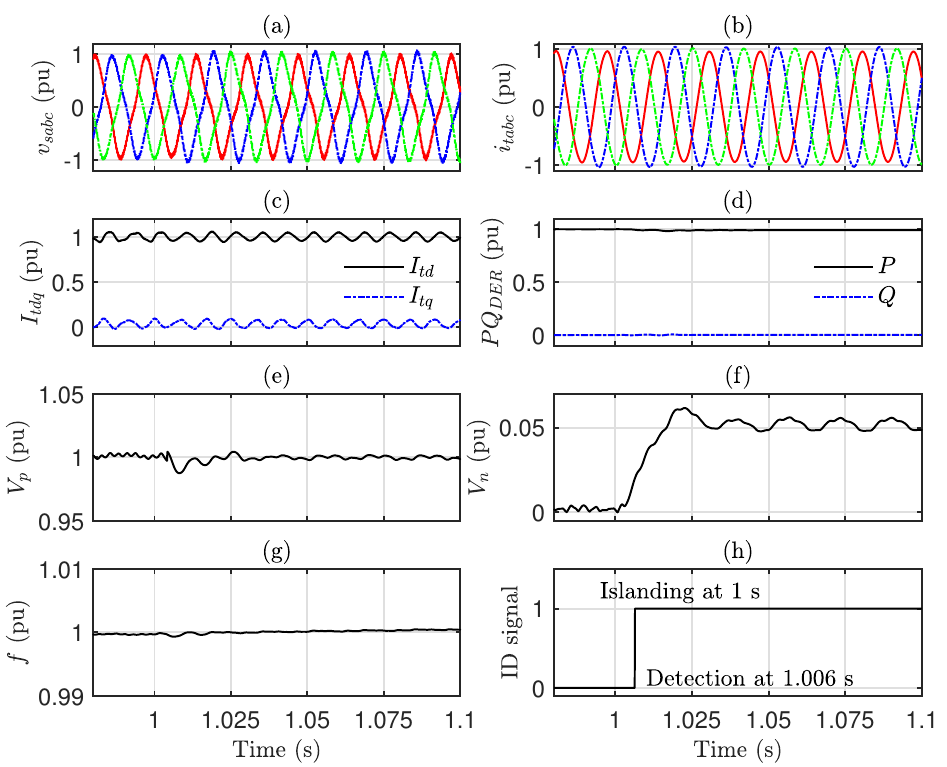
Figure 8. L -type filter case: Performance of the proposed controller under the IEEE1547 anti-islanding test: ( a ) three-phase PCC voltages; ( b ) three-phase inverter terminal currents; ( c ) d - and q -axis components of the inverter terminal current; ( d ) fundamental frequency power components of the DER unit; ( e , f ) amplitudes of positive- and negative-sequence PCC voltage, respectively; ( g ) frequency; and ( h ) ID signal.